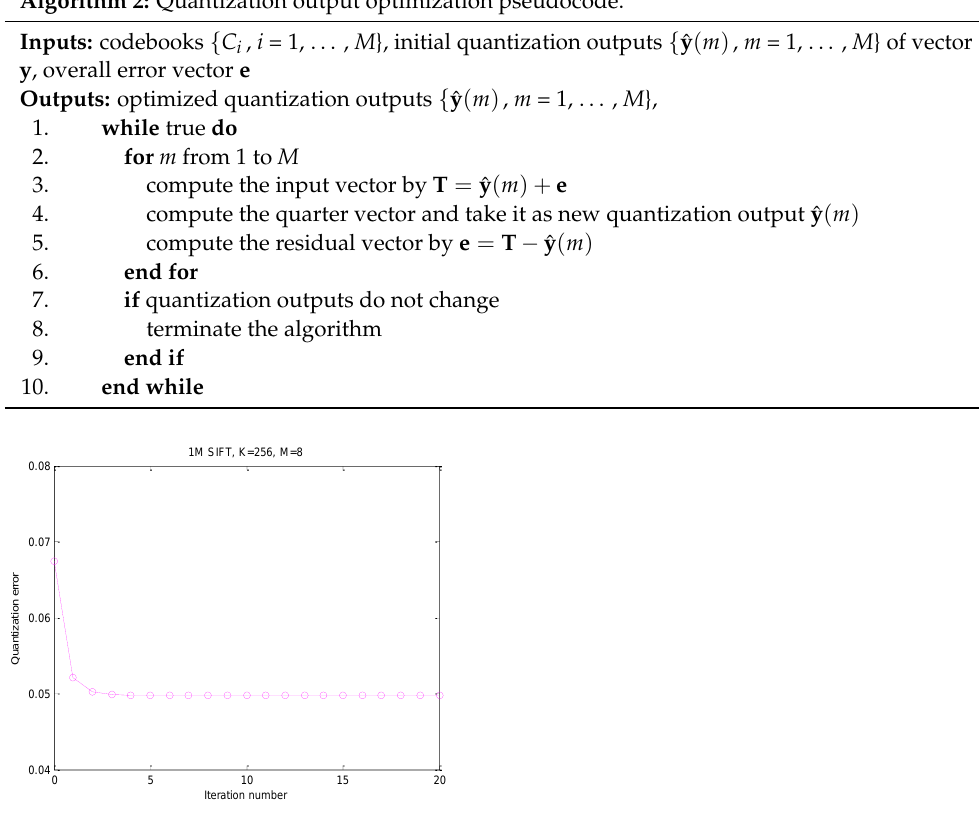
Algorithm 2. Quantization output optimization pseudocode. Algorithm 2: Quantization output optimization pseudocode.